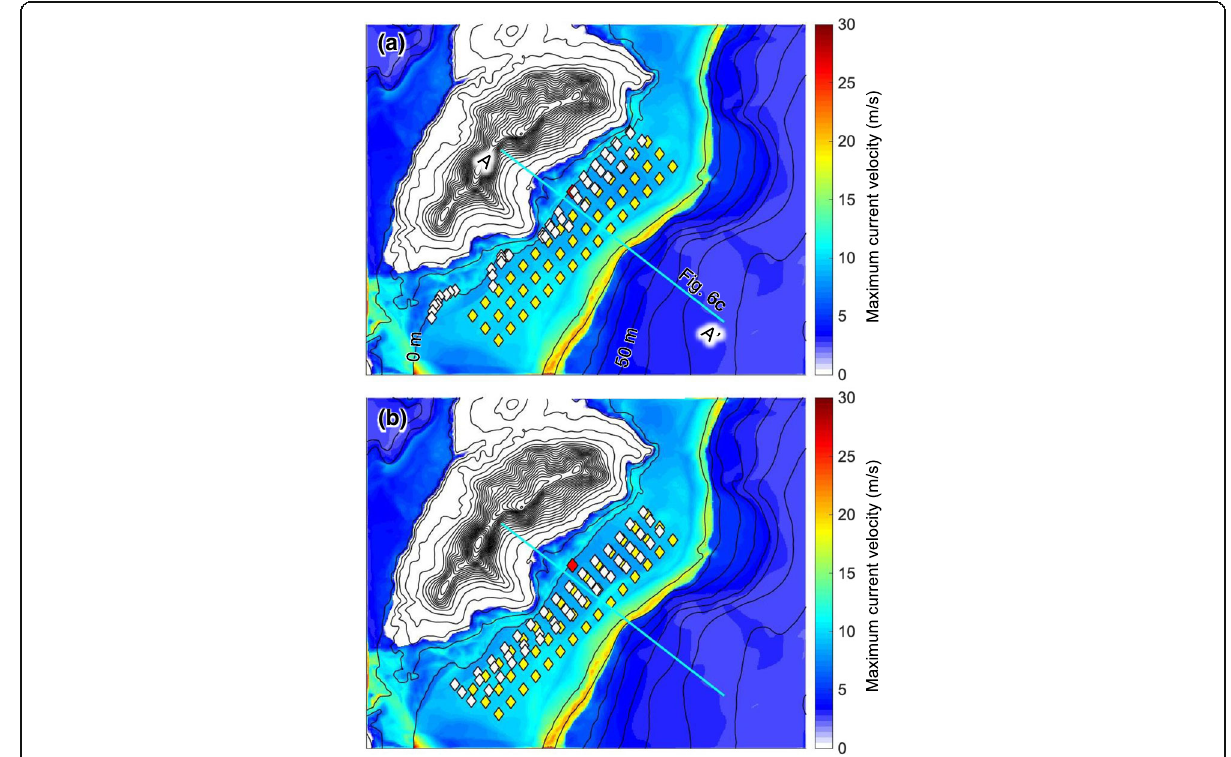
Fig. 7 Numerical results of coral transport by the 1771 Meiwa tsunami in region 4. a Average size boulder. b The largest boulder. Yellow, white, and red diamonds respectively denote original location, final stop position, and present location of Bari-ishi boulder. The line in a is the transect line in Fig.